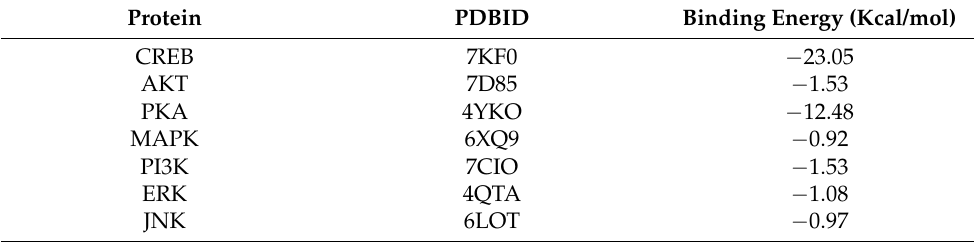
Table 1. The binding energy values between AA and different